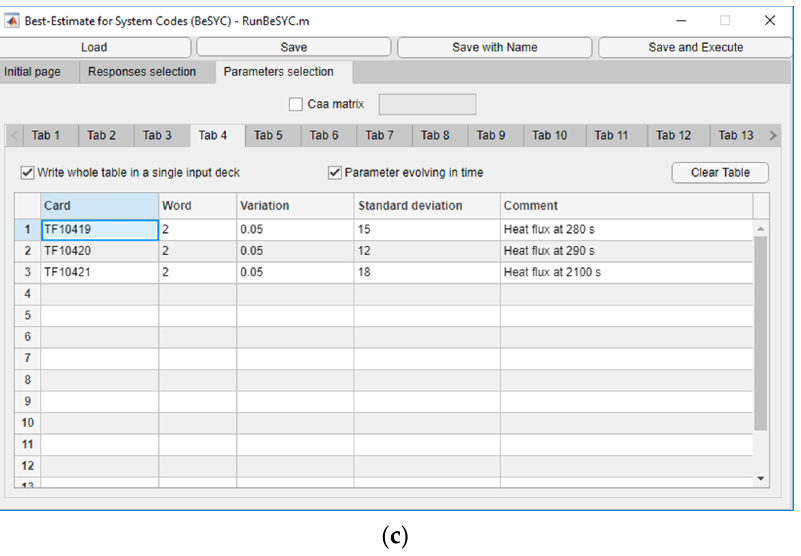
Figure 2. Flowchart of the BeSYC software: ( a ) main panel; ( b ) responses panel; ( c ) parameters panel.